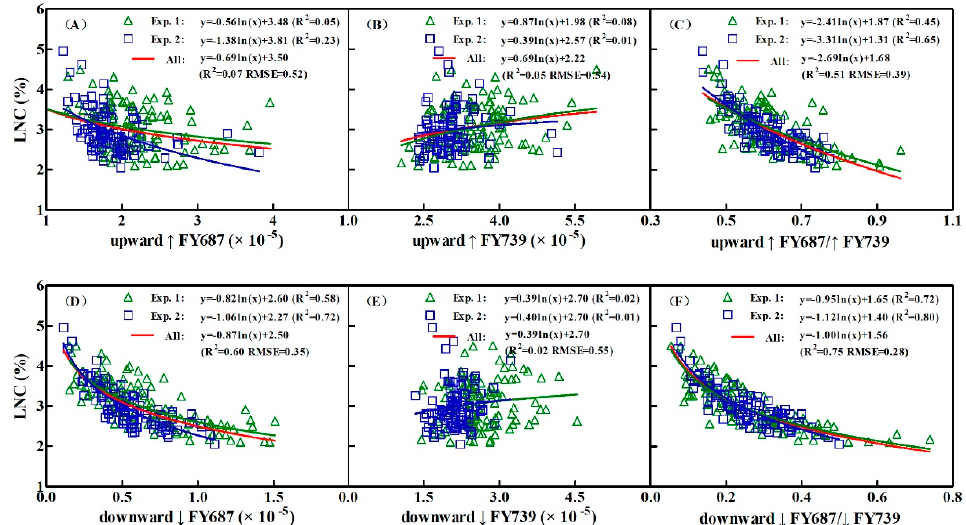
Figure 6. LNC plotted against SIF yield indices (Top row is the upward; Bottom row is the downward). ( A ) the upward ↑ FY687 (×10 − 5 ); ( B ) the upward ↑ FY739 (×10 − 5 ); ( C ) the upward ↑ FY687/ ↑ FY739; ( D ) the downward ↓ FY687 (×10 − 5 ); ( E ) the downward ↓ FY739 (×10 − 5 ); ( F ) the downward ↓ FY687/ ↓ FY739. Note: green, blue, and red lines are the best-fit function for the Experiment 1 (Exp. 1), Experiment 2 (Exp. 2), and the two datasets combined, respectively.